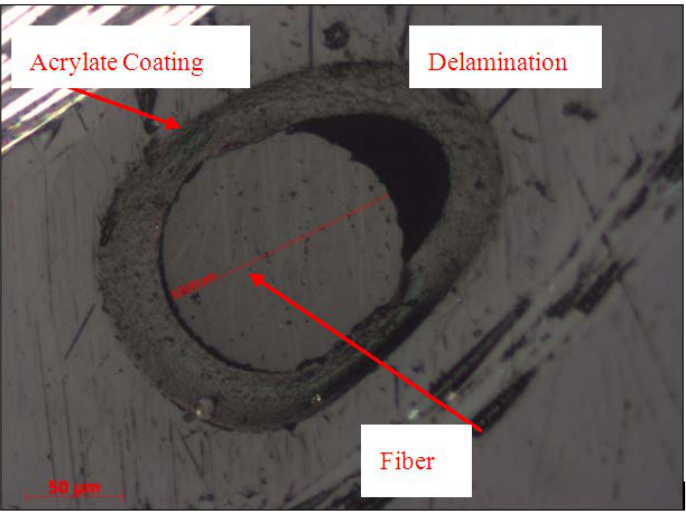
Figure 4. Micrograph section of an embedded acrylate-coated optical fiber. In this